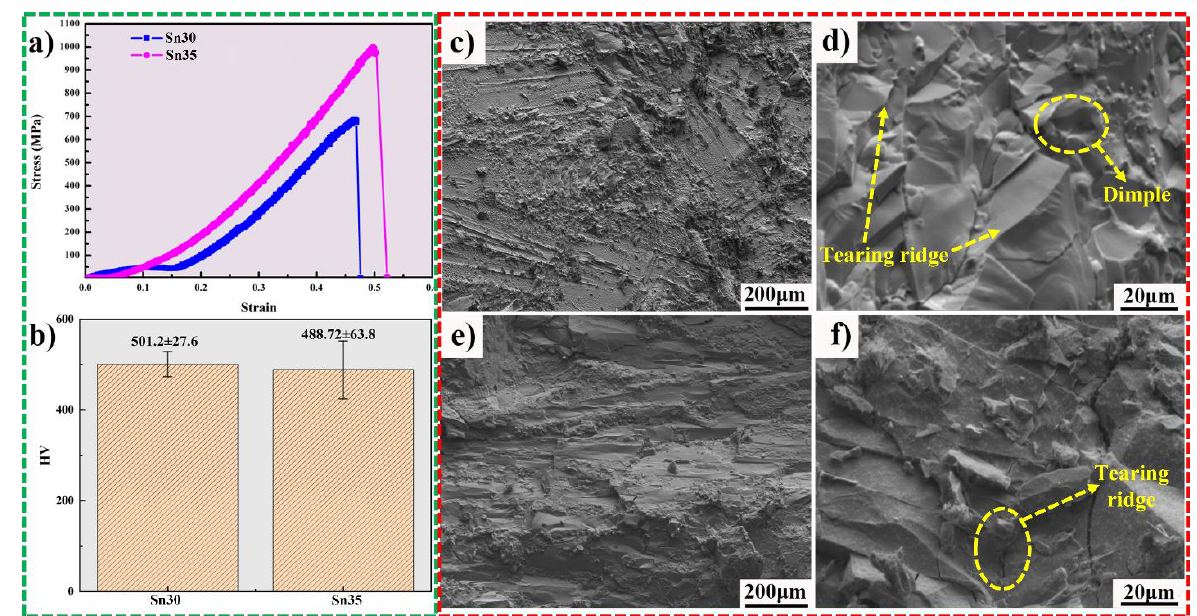
Figure 4. Compressive stress–strain curves and corresponding fracture morphologies of Sn30 BHEA and Sn35 BHEA: ( a ) stress–strain curves, ( b ) HV of Sn30 BHEA and Sn35 BHEA, ( c , d ) fracture morphology of Sn30 BHEA, ( e , f ) fracture morphology of Sn35 BHEA.